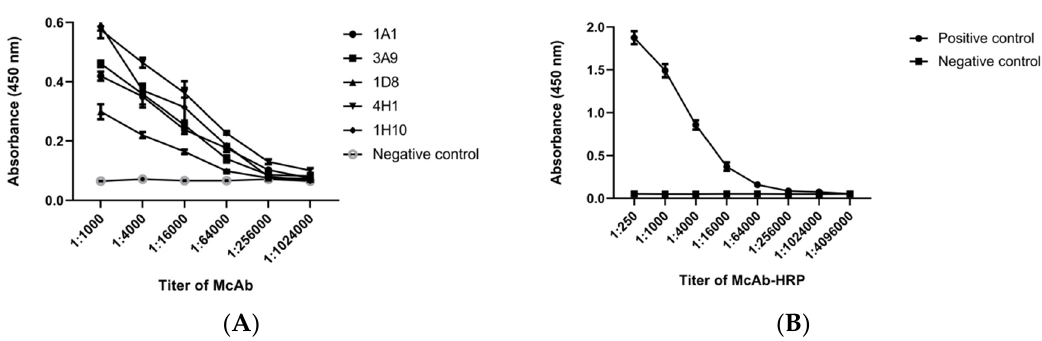
Figure 1. ( A ) The five monoclonal antibodies (1A1, 3A9, 1H10, 4H1, 1D8) selected for titer detection, and ( B ) the results of titration assays of monoclonal antibody horseradish peroxidase (McAb-HRP). Error bars represent the standard deviations (SDs) of two independent assays.